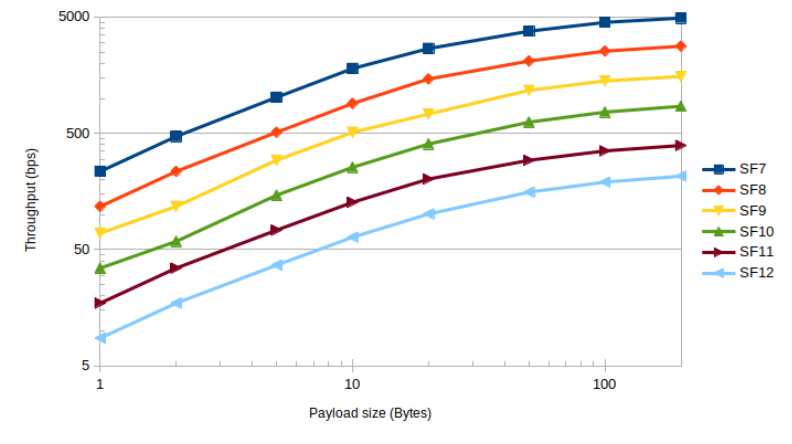
Figure 4. Throughput between two TTGO LORA32